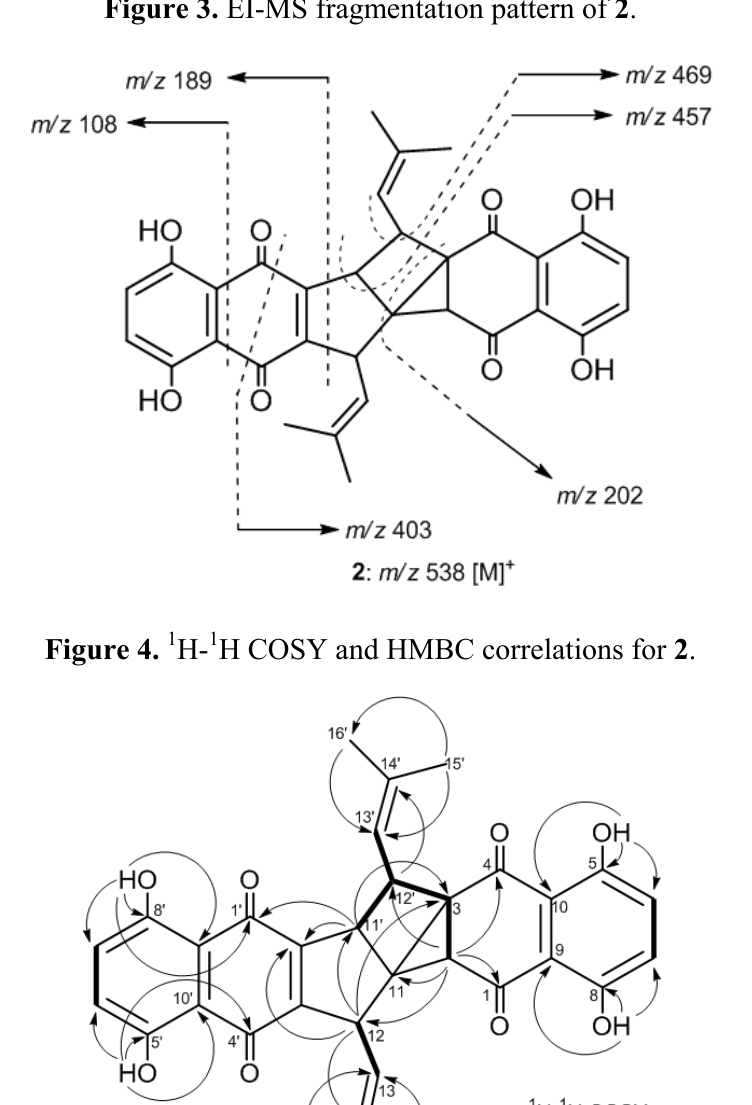
Figure 3. EI-MS fragmentation pattern of 2 .